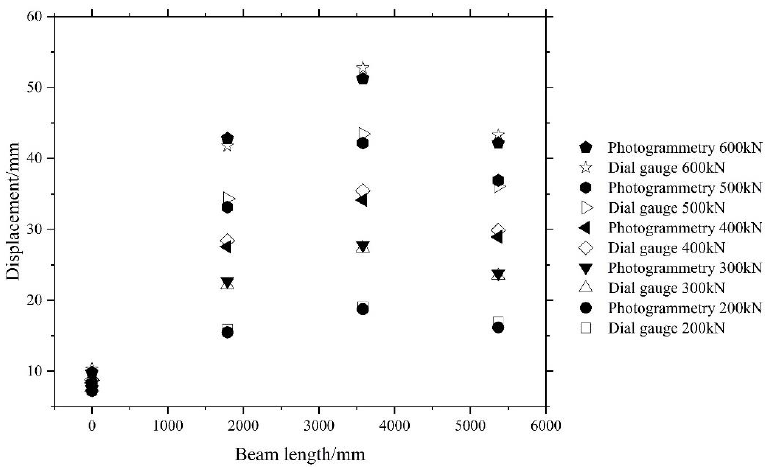
Figure 18. Error comparison chart. Table 4. Comparison of displacement measurement error.